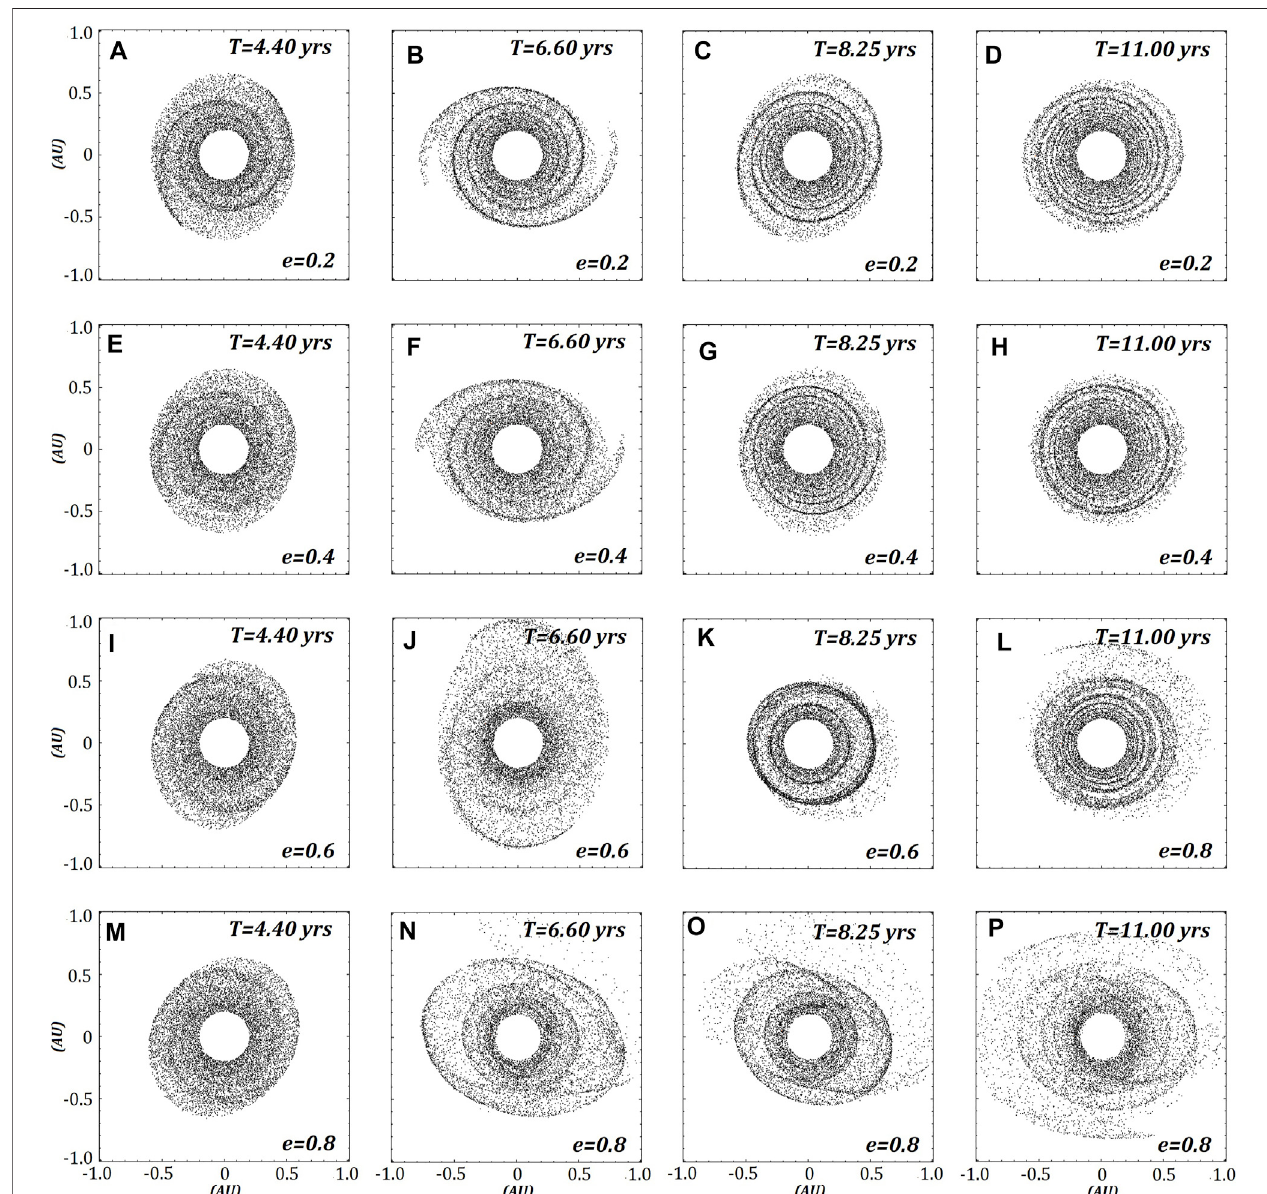
FIGURE 3 | Four models of a retrograde ring around J1407b ( M (cid:1) 20 M J ) for one complete orbit ( P (cid:1) 11 yrs ) about the primary. The x and y axes represent the instanteous positions of ring particles around J1407b, which is at the origin. The rows represent each model, where e (cid:1) 0 . 2 (A – D) , e (cid:1) 0 . 4 (E – H) , e (cid:1) 0 . 6 ( i − l ) and e (cid:1) 0 . 8 ( m − p ) , while the column represents a snapshot in time at T (cid:1) 4 . 40 yrs ( A , E , I & M ) , T (cid:1) 6 . 60 yrs ( B , F , J & N ) , T (cid:1) 8 . 25 yrs ( C , G , K & O ) , T (cid:1) 11 . 00 yrs ( D , H , L & P ) , where all models began at